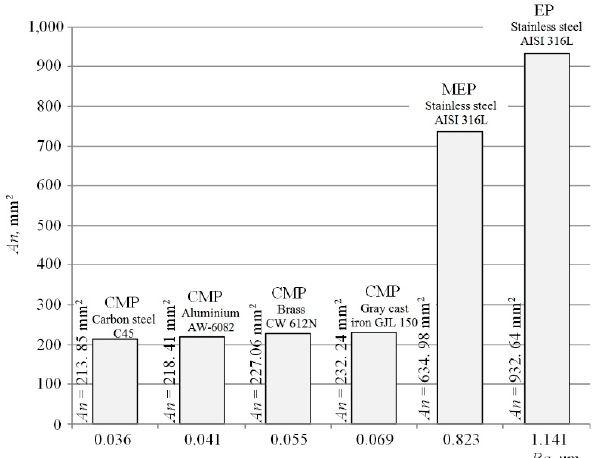
Figure 7. The set of average values of An area (of the bright regions of scattered light image) vs. Ra roughness average for surfaces after finishing by various variations of the polishing process.